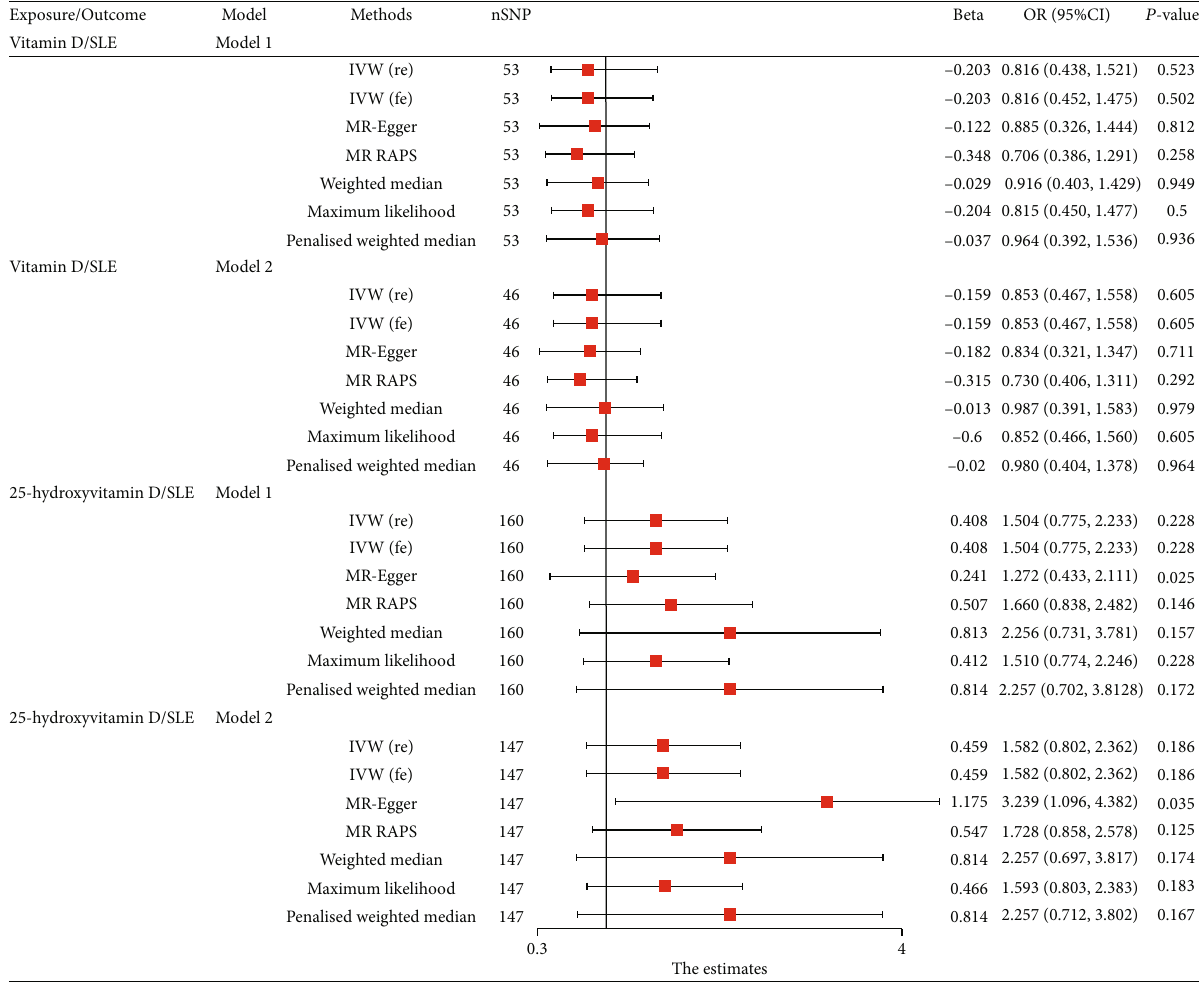
Figure 4: MR results for causal role of serum vitamin D and 25-hydroxyvitamin D levels on SLE. MR-RAPS method was not applicable for causal e ff ect of SLE on vitamin D with model 2 for limited SNPs. SLE: systemic lupus erythematosus; SNP: single-nucleotide polymorphisms; IVW: inverse variance weighted; MR-RAPS: MR-robust adjusted pro fi le